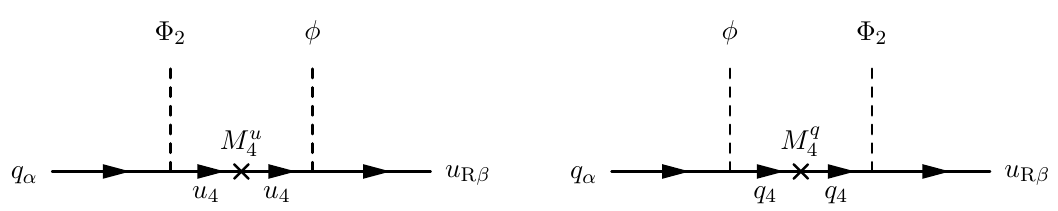
Figure 4 . Effective interaction between quark doublets and up-type